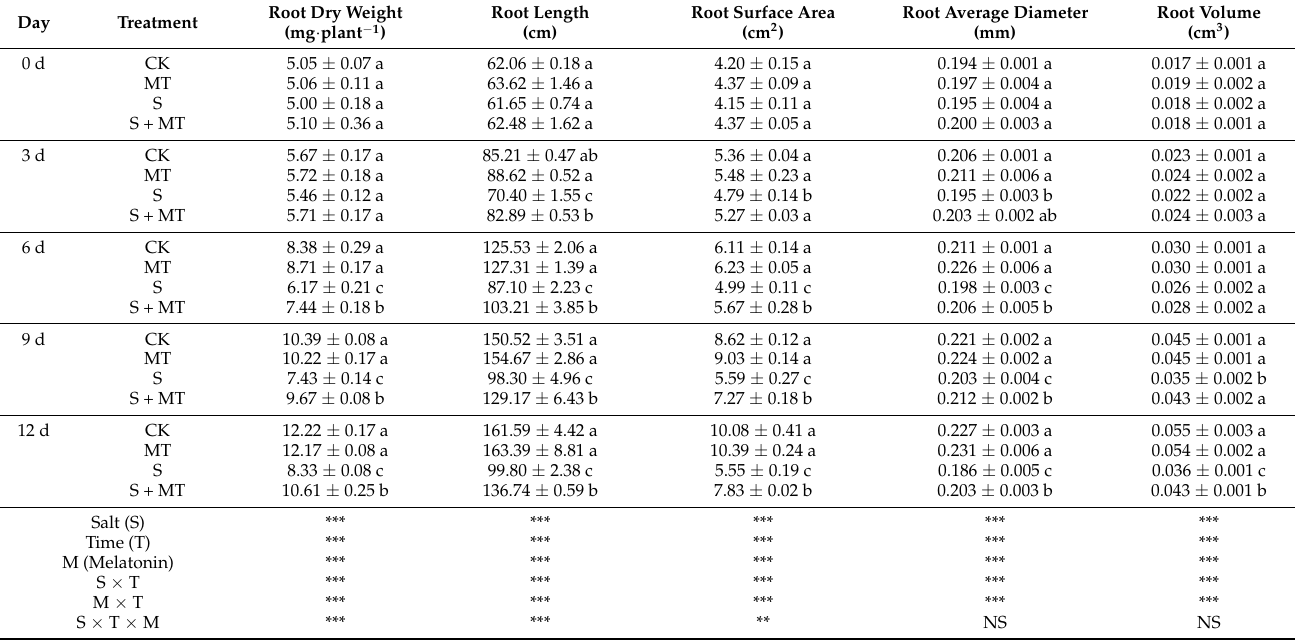
Table 1. Effects of the foliar application of melatonin on the root characteristics of C. leucochlora seedlings under salt stress. For each treatment day, different letters within a column indicate signifi- cant differences according to the Duncan’s multiple range test at p < 0.05 ( n = 5). Mean ± standard error of five replicates. Significance levels are presented for each main effect or interaction. NS: not significant; *** p < 0.001; ** p <